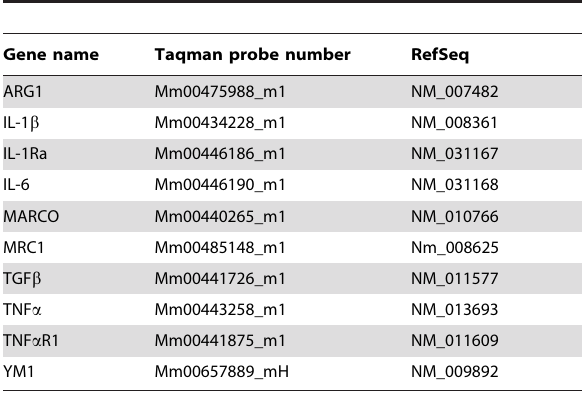
Table 1. Gene expression probes used for the real-time RT- PCR